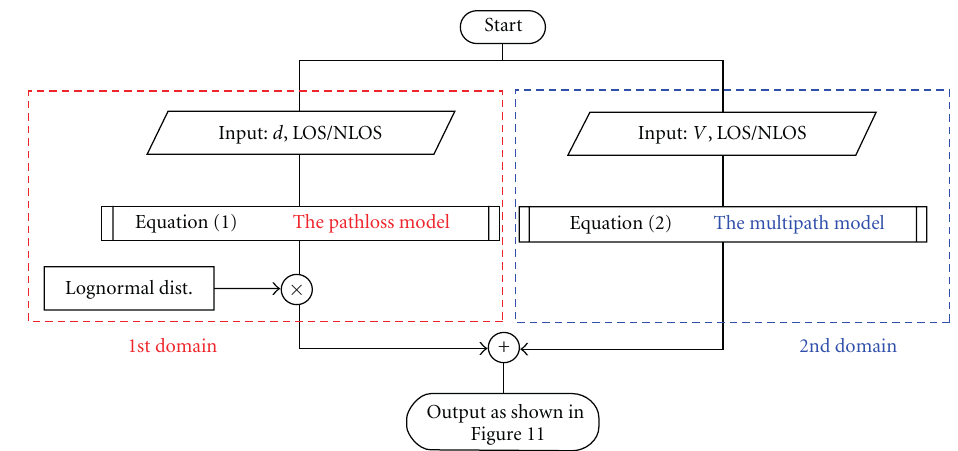
Figure 10: The flow chart of our model realization process.